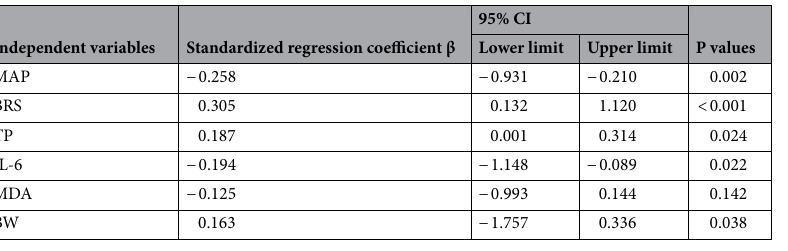
Table 8. Multiple regression analysis of nitric oxide (as dependent variable) with various parameters (as independent variables) in study group at 36th week of gestation. C.I. confidence interval, MAP mean arterial pressure, BRS baroreflex sensitivity, TP total power of HRV, IL-6 interleukin-6, MDA malondialdehyde, BW birth weight.